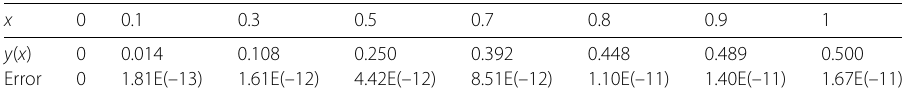
Table 4 For Example 5, showing the numerical solutions and the absolute errors obtained by the BSFM at different